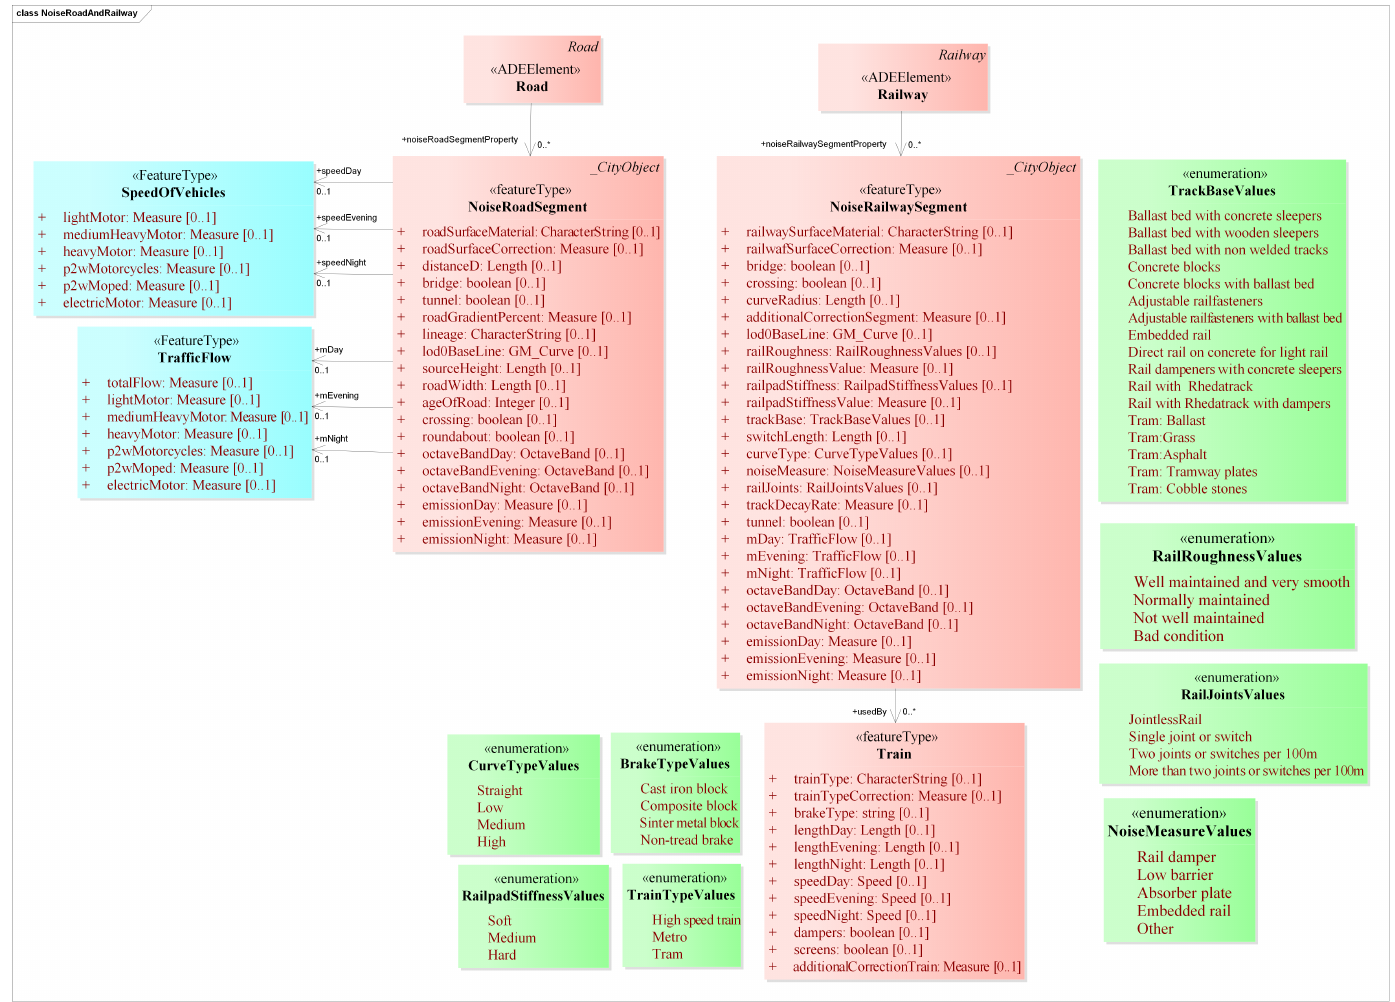
Figure 6. UML model of the CityGML Road and Railway (shown in red) extended to include noise-related